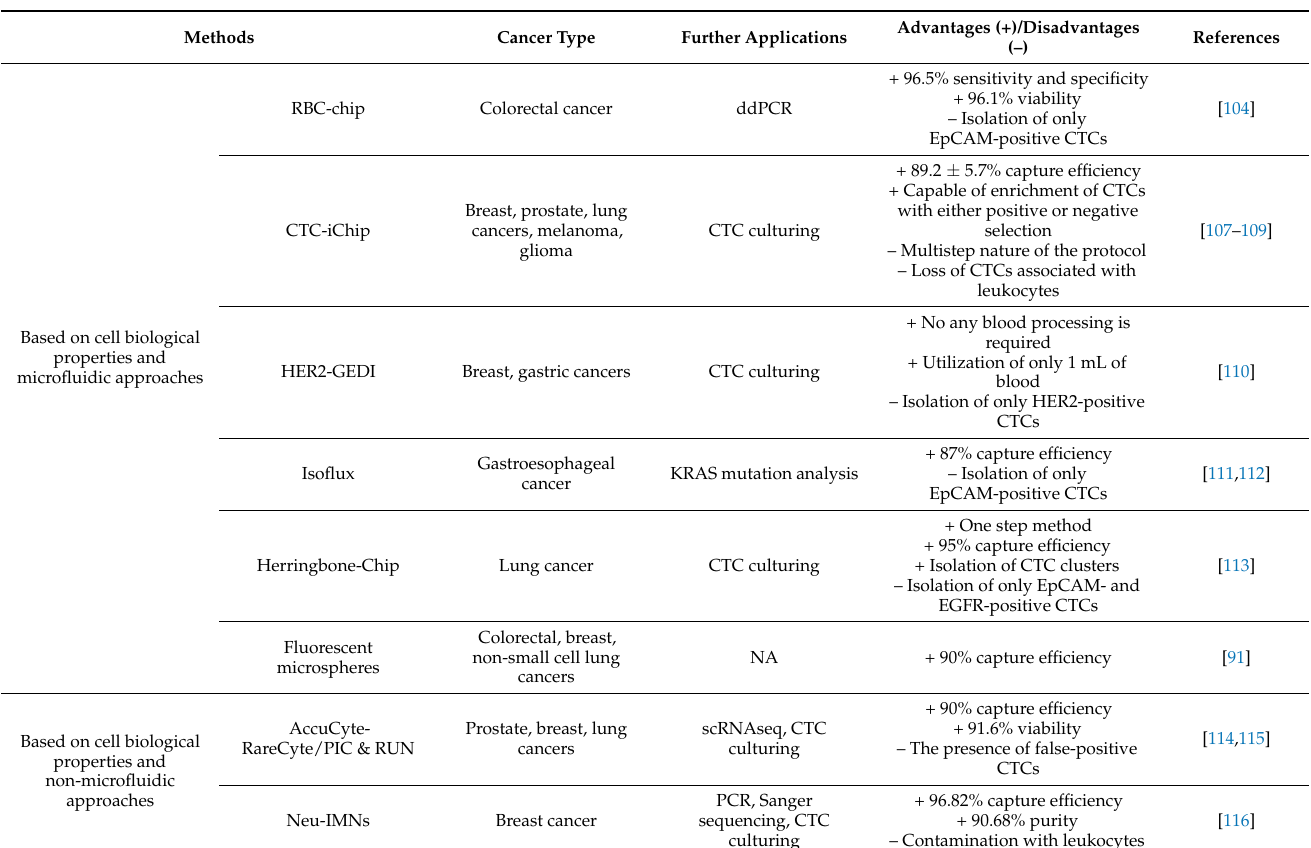
Table 3. Combined methods for isolating viable